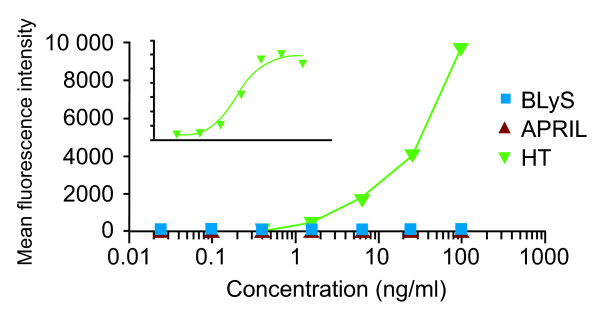
Detection of BLyS/APRIL HTs by using a bead-based HT immunoassay. The assay has a broad detection range (~25 ng/ml to ~100 pg/ml; see standard curve, inset), with an LOQ of ~100-313 pg/ml in the presence of serum (EC50~6 ng/ml). The average serum sample size required is 25 μl, and the total assay time is 2 hours. The assay does not detect BLyS or APRIL homotrimers. APRIL, a proliferation-inducing ligand; BLyS, B-lymphocyte stimulator; EC50, 50% effective concentration; HT, heterotrimer; LOQ, limit of quantitation.